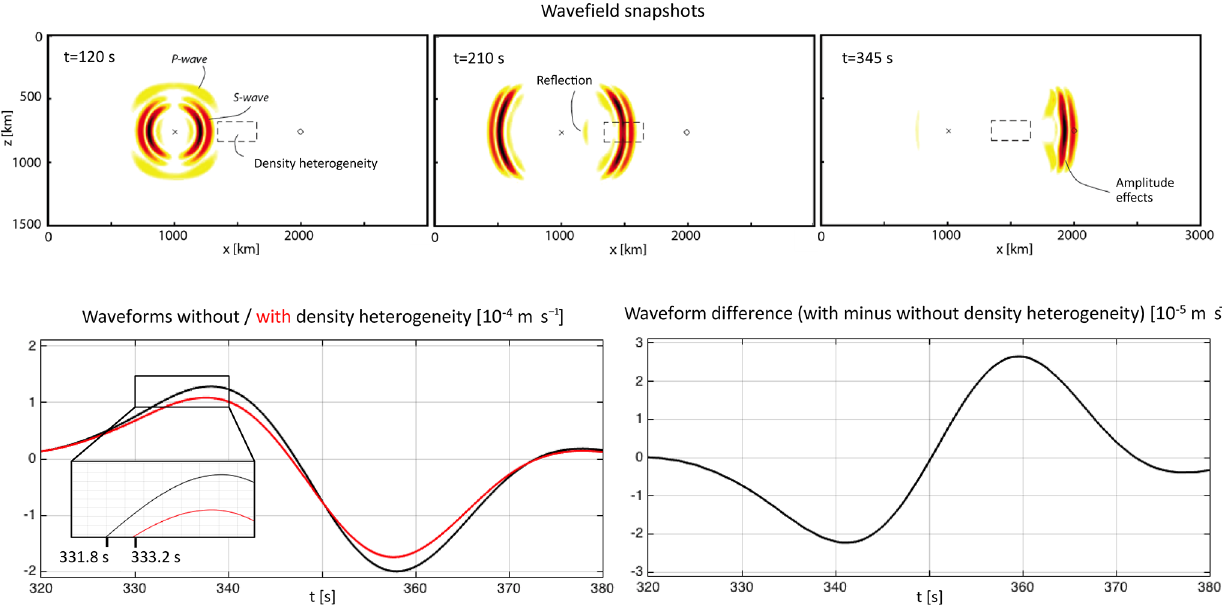
Figure 10. Illustration of finite-frequency travel-time shifts induced by a 38% density perturbation. Top row: Wave field snapshots before, during and after the wavefront interacts with the density heterogeneity, marked by the dashed box. The interaction with the density hetero- geneity causes reflections and amplitude changes of the direct wave. The onset of the wavefront, however, remains unaffected. Bottom row: Synthetic seismograms taken at the position of the black circle in the top-row snapshots. The actual onset time of the waveforms at around 320s is identical for simulations with (red) and without (black) density heterogeneity. However, the waveform differences, plotted to the right, induce a cross-correlation time shift of ∼ 1s. Locally, for example around 332s, the time shift reaches 1 .